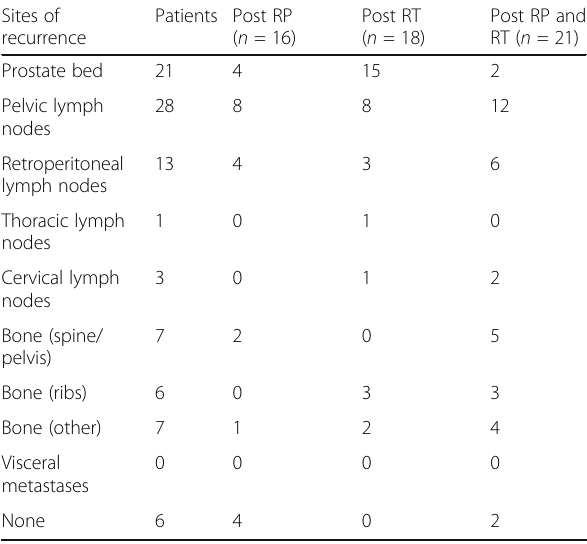
Table 2 Sites of suspected recurrence on PSMA Sites of Patients Post RP recurrence ( n = 16)